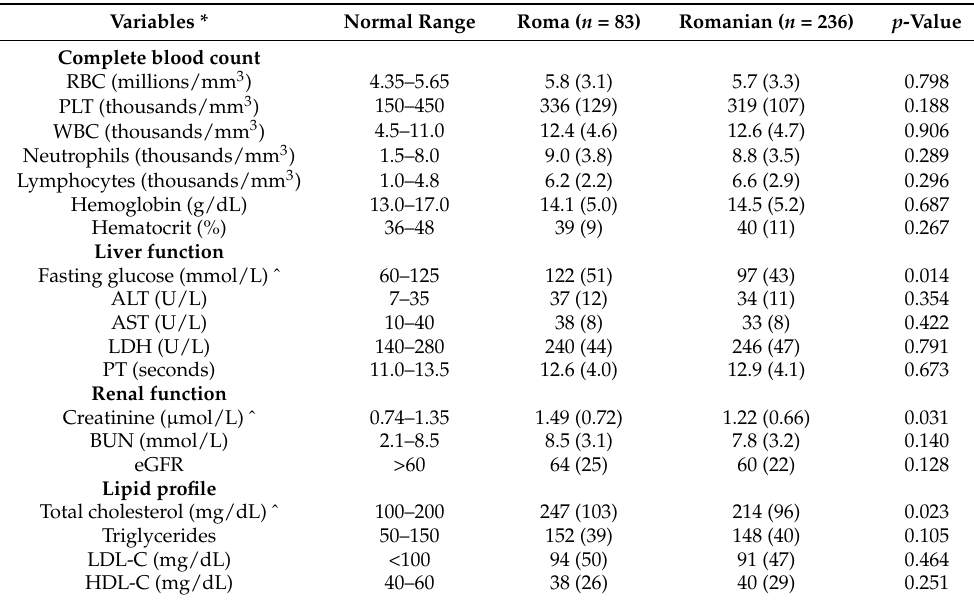
Table 3. Comparison of laboratory findings at admission between patients of Roma and Romanian ethnicity with severe COVID-19.